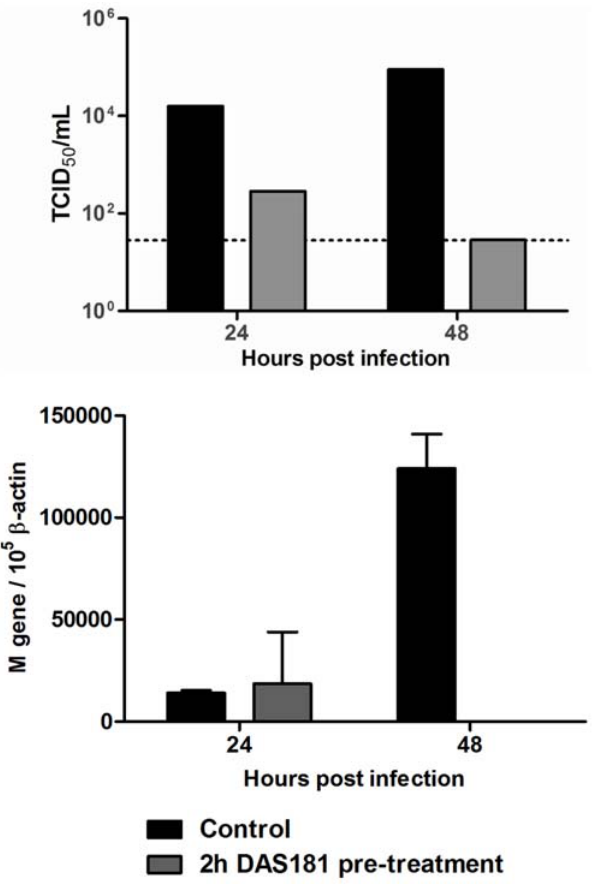
Figure 3. DAS181 inhibits pandemic IFV A(H1N1) viral replication in ex vivo human bronchi tissue. Human bronchi tissues were collected from patients undergoing lung resection and immediately placed on air-liquid interface membranes for culturing. Within 12 hours the tissues were pretreated with PBS (‘‘control’’) or DAS181 (10 m g/cm 2 , ‘‘2 h DAS181 pretreatment’’) for 2 hours at 37 u C. After washing, the tissues were infected with pandemic influenza A(H1N1) A/California/04/2009 (10 6 TCID 50 /tissue) for 1 hr and then washed. Tissues were then incubated at 37 u C for 24 or 48 hrs before washing the apical surface and determining viral titer in either the apical wash by TCID 50 on MDCK cells (top panel), or within tissue homogenate by RT-PCR analysis of viral M-gene RNA level normalized to cellular b -actin RNA level (bottom panel). Dotted line represents limit of detection of the TCID 50